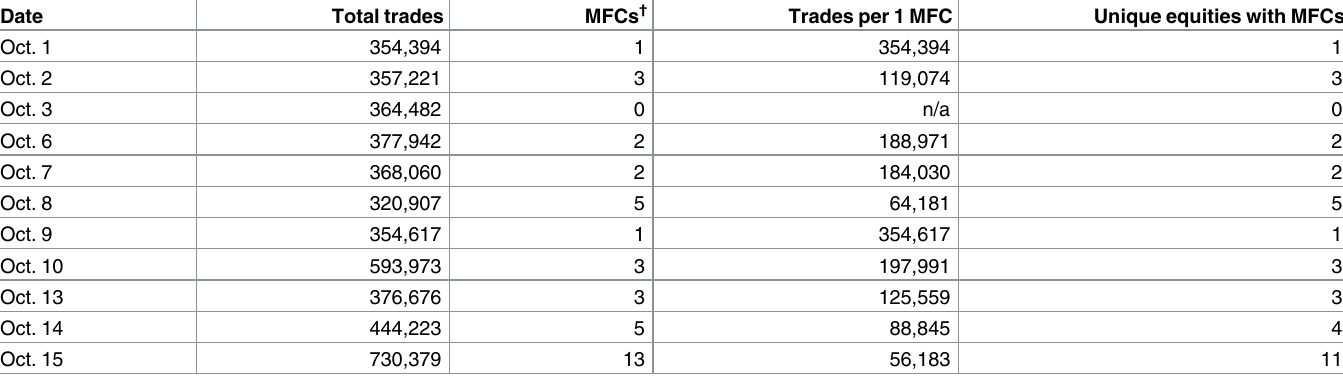
Fig 2. Number of unique equities that experienced mini flash crashesduring Control Period 1 (9:30–9:33 windows). The number of uniqueequities that experienced mini flash crashes duringthe test windowis 2.2 times greater than the greatest numberof uniqueequitiesthat experienced mini flash crashes duringany other 9:30–9:33window. https://doi.org/10.1371/journal.pone.0186688.g002 Table 1. Total trades executed and mini flash crashesduring Control Period